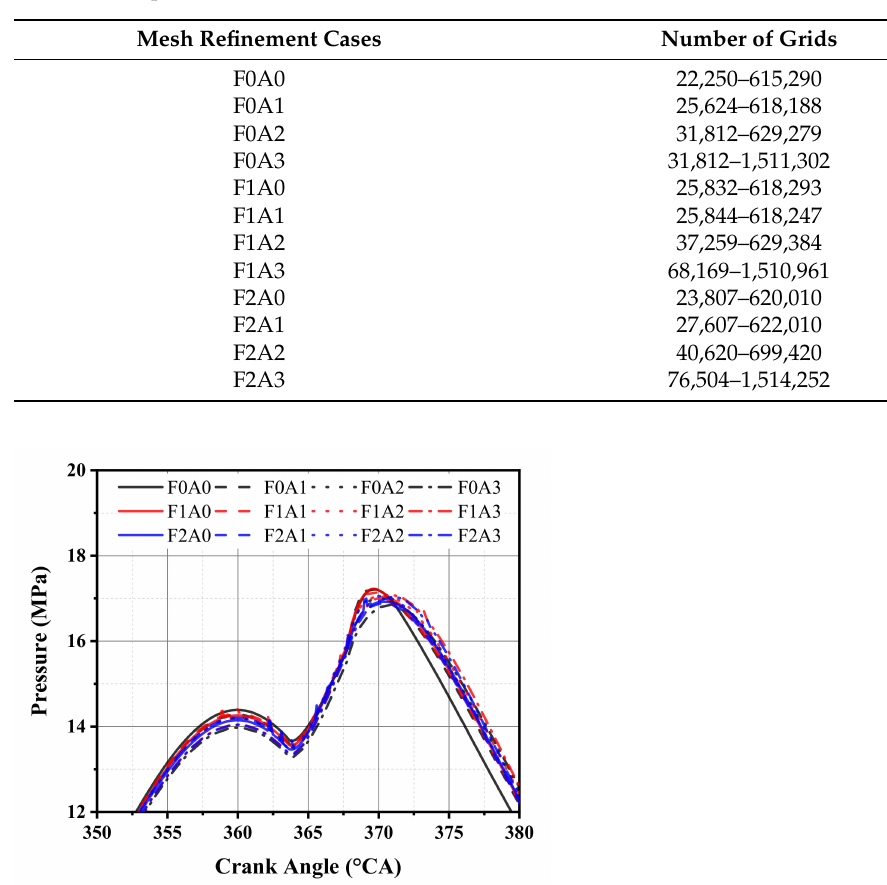
Table 7. The specification of mesh refinement cases.